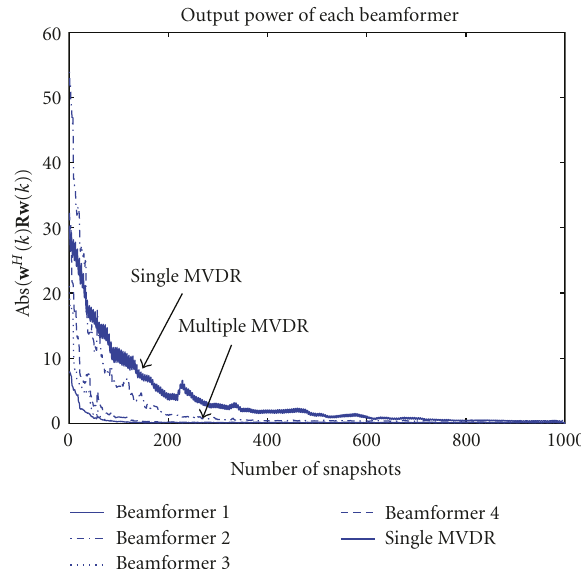
Figure 5: Output power of the LMS algorithm at each